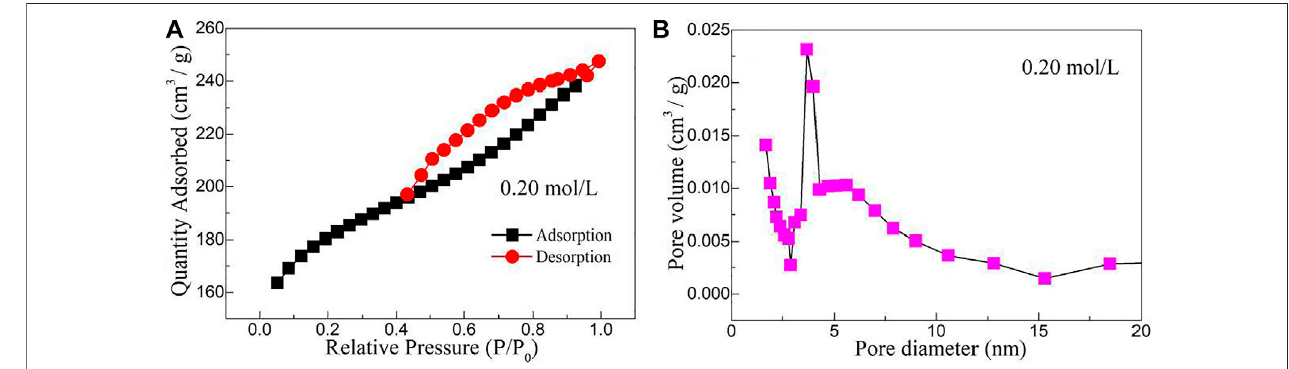
FIGURE 7| (A) Nitrogen adsorption – desorption isotherm and (B) pore size distribution of molybdenum disul fi de/biological structure carbon composites prepared by the hydrothermal calcination method with the concentration of molybdenum chloride of 0.20